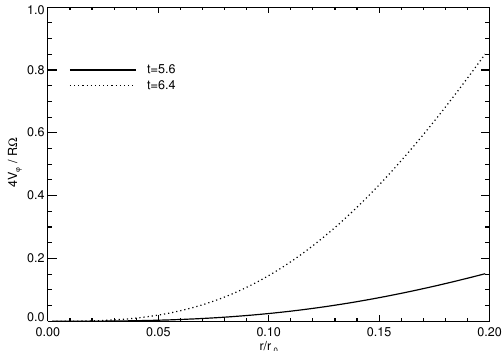
Figure 4. The normalized toroidal velocity as a function of r/r 0 in the inner vortex region for R = 50m and (cid:127) = 0 . 1s − 1